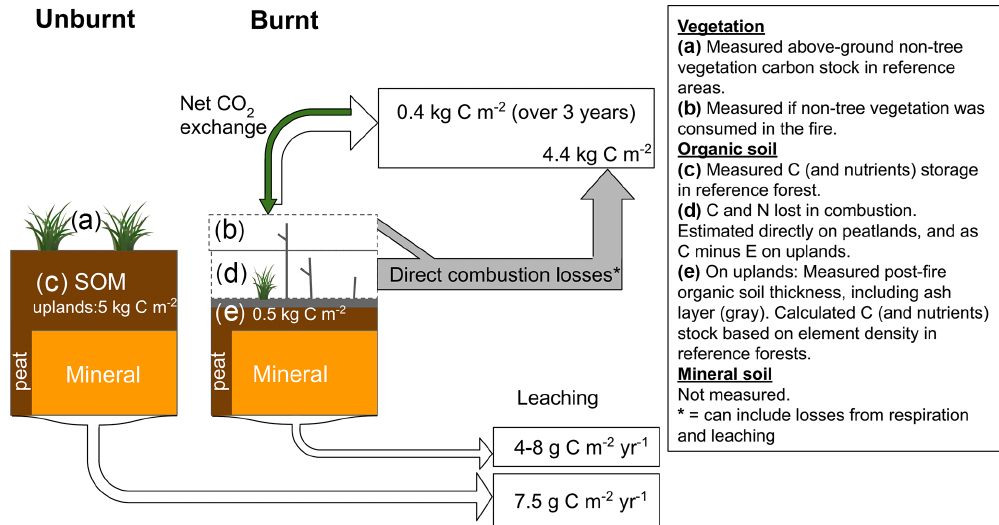
Figure 6. Conceptual C flow diagram during the first 3 years after the fire in a boreal forest catchment. Post-fire leaching is given as a range for the first 3 years, and leaching from an unburned catchment (Gärsjöbäcken, Table 2) is the mean of the 4 years before the fire